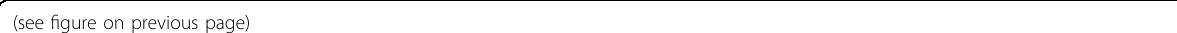
Fig. 2 Nuclear phase separation of the proteasome for degradation of female germline cells. A Dotplot showing the expression of ubiquitination associated genes among subclusters. B Expression levels of key genes in proteasome foci formation among subclusters. C Immuno fl uorescence analysis of proteasome foci using Psmb2 antibody in ovotestis (secondary antibody, FITC-conjugated immunoPure goat anti- rabbit IgG(H + L)). Proteasome foci were located in the nuclei of germ cells (white solid arrowheads) and in the cytoplasm of supporting cells (white hollow arrowheads). The nuclei were stained with DAPI. The outer dotted circle indicates the degrading region and the inner dotted circle shows the germinal cradle. Scale bar: H&E, 100 µm; immuno fl uorescence, 20 µm. D Formation of proteasome foci in the nuclei of CHO cells. The cells were treated with 50 µM MG-132 for 1 h and then stimulated with 0.2 M sucrose for 30 min. PSMB2 (green) and RAD23B (red) were colocalized in the nuclei. The nuclei were stained by DAPI. The enlarged images originated from the regions with white square. Scale bar, 5 µm. E Overexpression of Rad23ba promotes the formation of proteasome foci. Endogenous proteasome foci were detected by PSMB2 antibody in CHO cells. PSMB2 (green) and Rad23ba (red) were colocalized in the nuclei. The nuclei were stained with DAPI. The cells were treated with 50 µM MG-132 for 1 h and then stimulated with 0.2 M sucrose for 30 min. The enlarged images originated from the regions with white square. Scale bar, 5 µm. F Statistical analysis showing the proteasome foci number per cell. Twenty cells were counted for each group. Data were mean ± SD, ** P < 0.01. G Co-localization of Psmb2 (red) and Rps26 (green) in nucleus. The cells were stimulated with 0.2 M sucrose for 30 min. The nuclei were stained by DAPI. Scale bar, 5 µm. H Proteasome foci fusion in living CHO cells expressing GFP-Psmb2. The cells were treated with 0.2 M sucrose. Right panel, enlarged time-course views of the square in the left panel. Scale bar, 2 μ m. I The diagram indicating the nuclear phase separation of proteasome and ubiquitylated protein degradation. The proteasome foci consist of Rad23b, polyubiquitin chain proteins, and